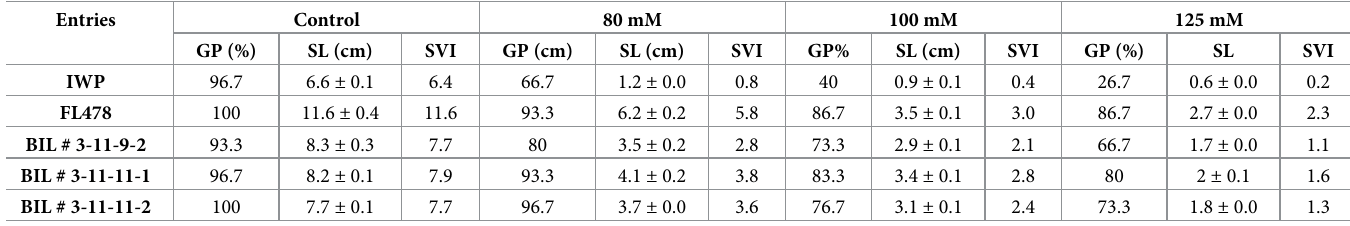
Table 5. Effects of salt stress on seed germination of parents and BILs.